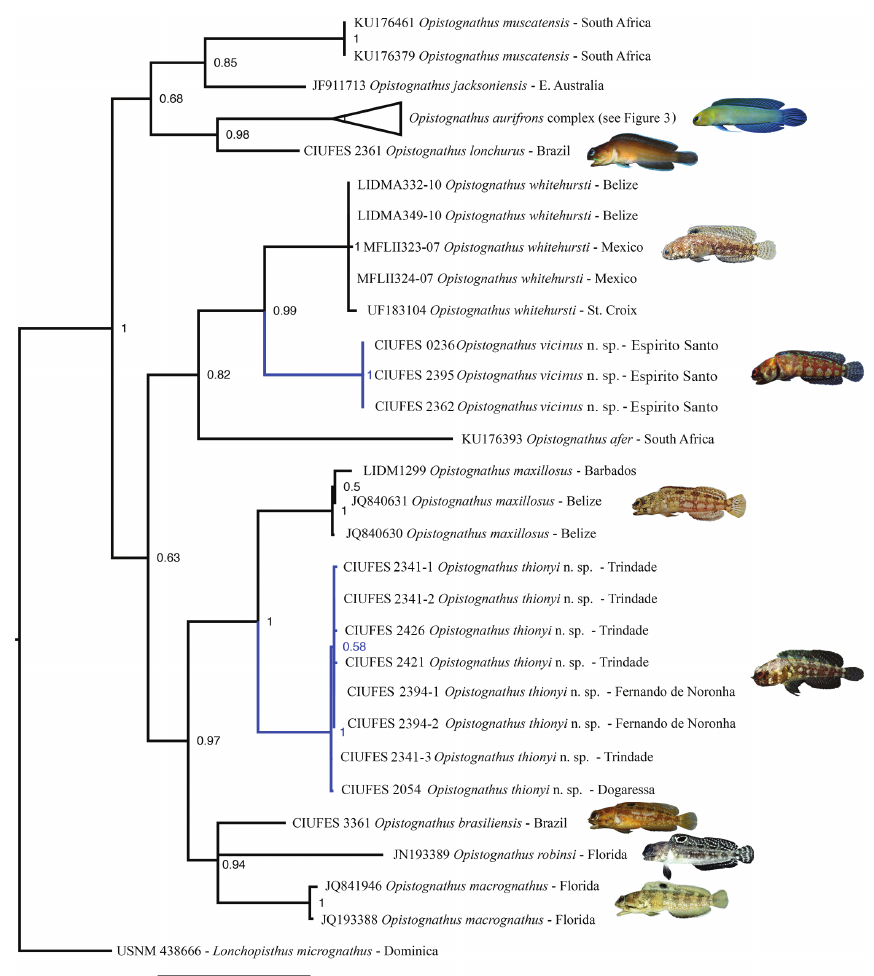
Figure 23. Bayesian inference phylogeny of western Atlantic Opistognathus based on COI data. Support values are Bayesian posterior probabilities. For clarity the clade containing Opistognathus aurifrons is col- lapsed (see Figure 24 for this clade expanded). Scale bar units are expected number of substitutions per